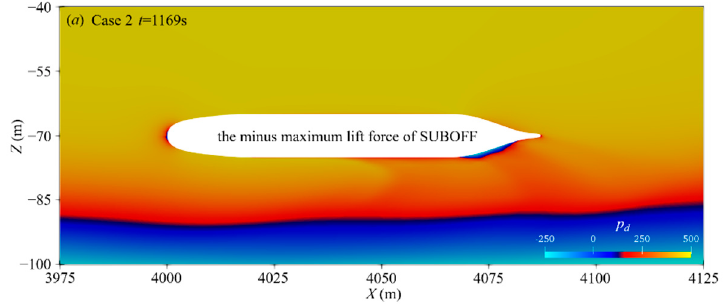
Figure 15. Dynamic pressure field around the SUBOFF.